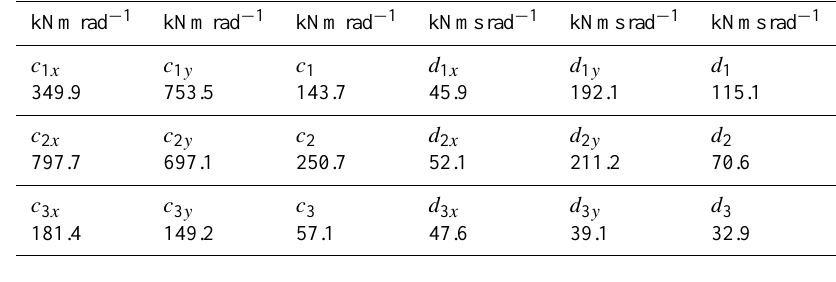
Table 1. Identified elasticity parameters.